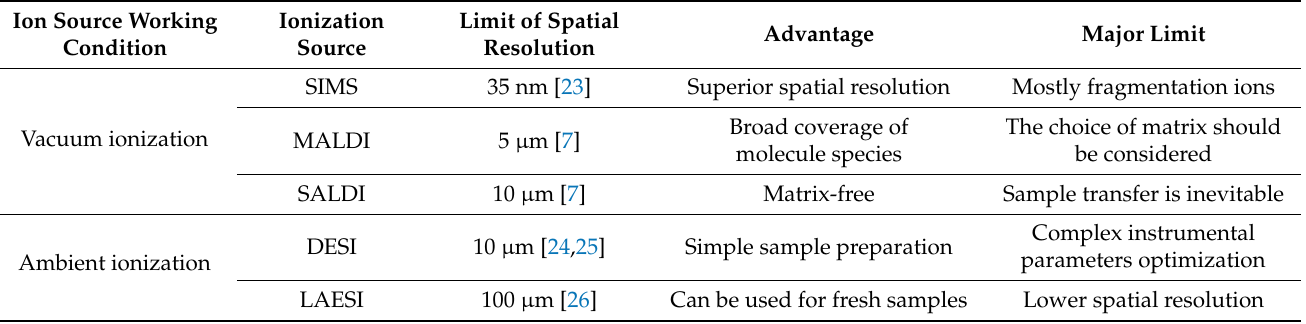
Table 1. Ionization techniques used in microbial